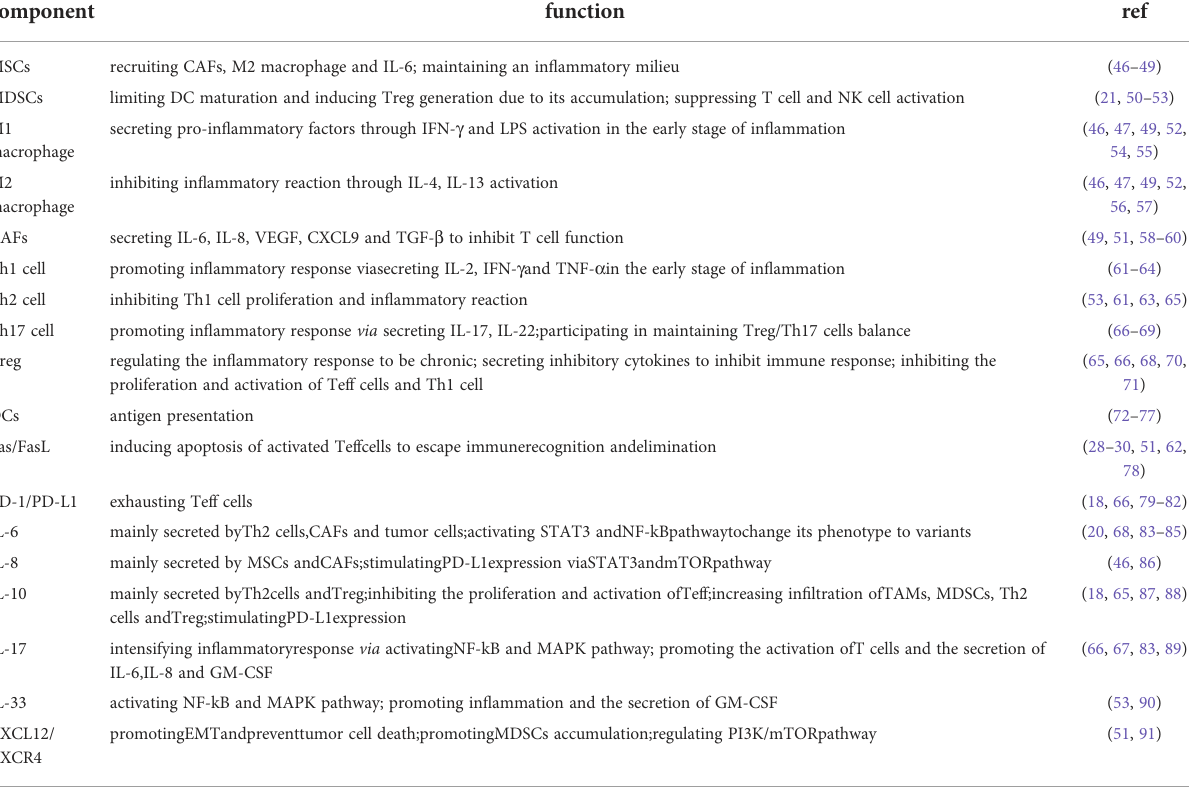
TABLE 1 The main component and function of